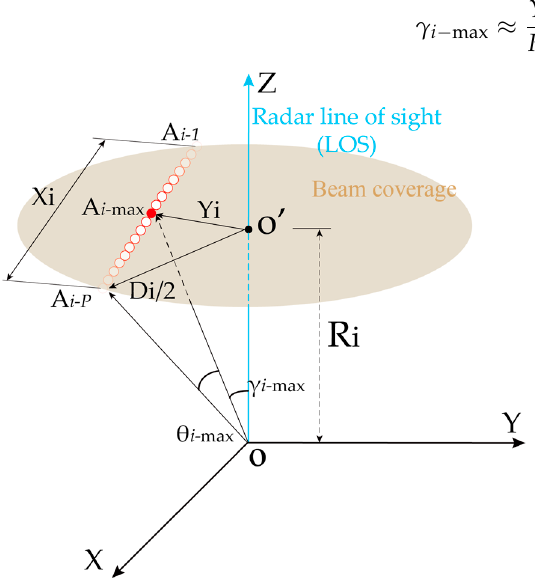
Figure 5. Schematic diagram of the insect location model.